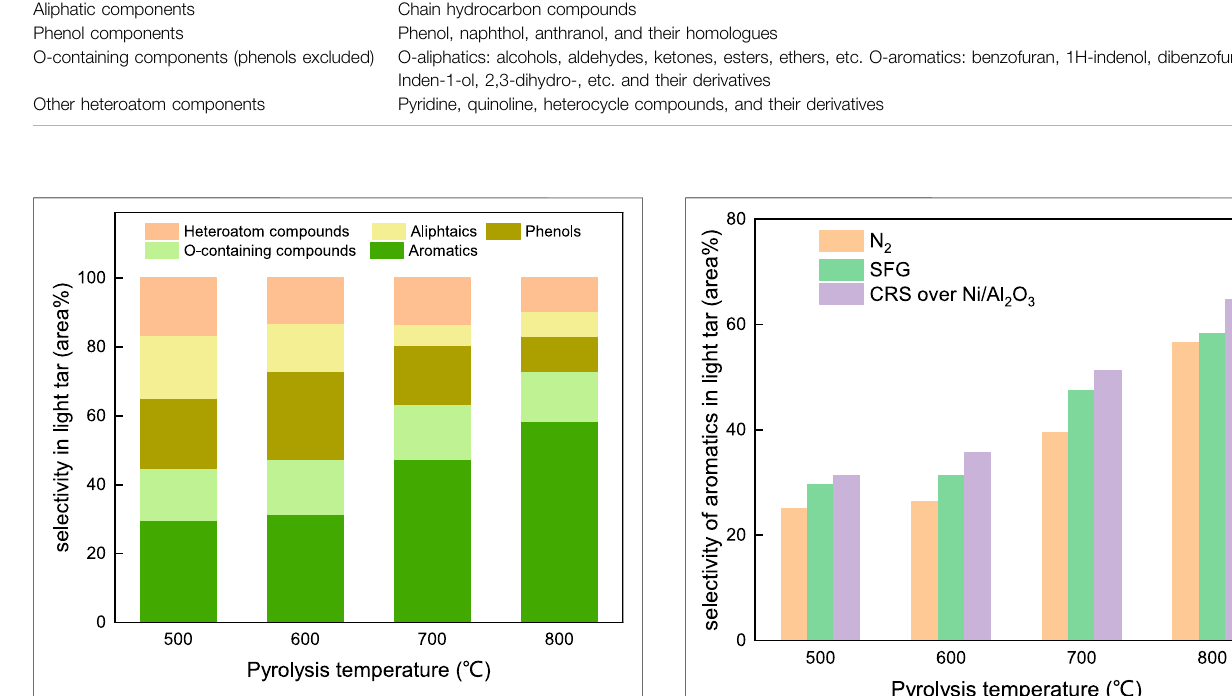
FIGURE 10 | The selectivity of the aromatic components under different